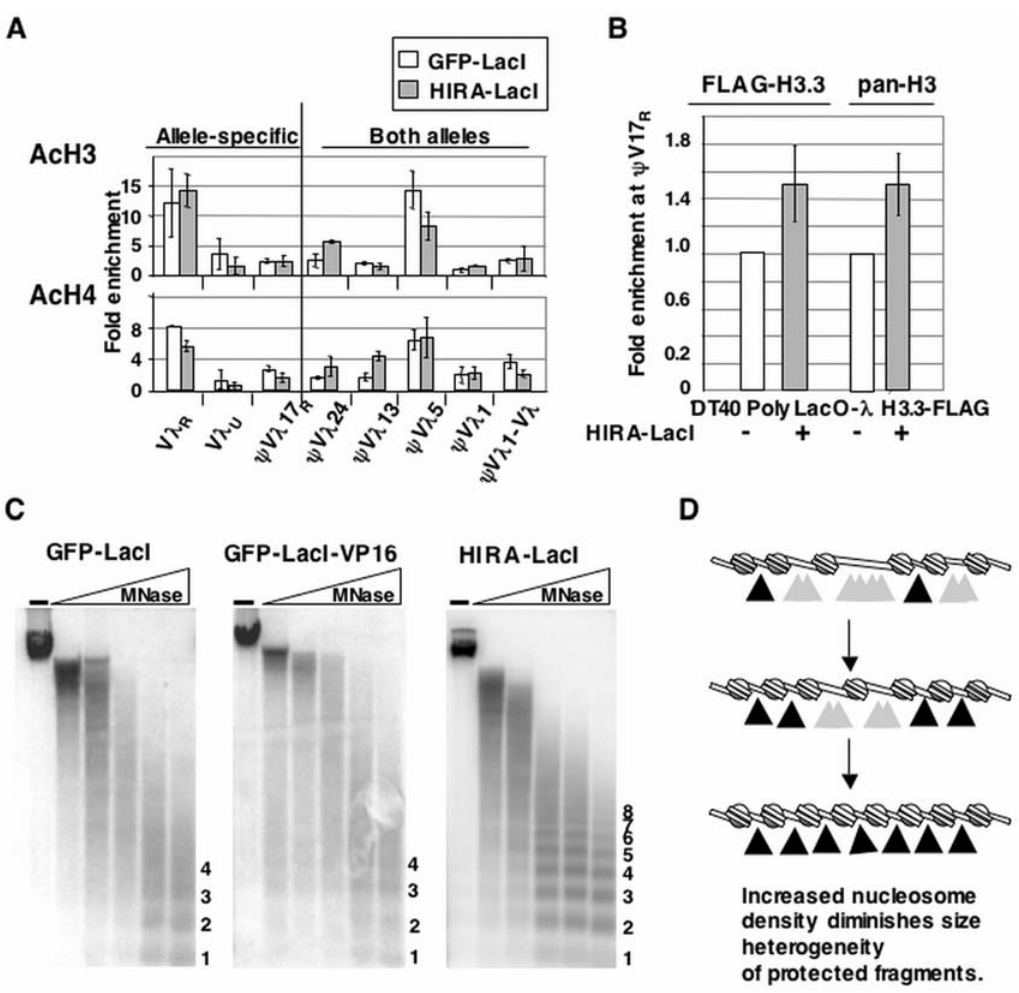
Figure 5. Tethered HIRA Enriches Local Levels of H3.3 and Alters Local Chromatin Structure. (A) Quantitation of enrichment of AcH3 (above) and AcH4 (below) at Ig l in DT40 PolyLacO- l GFP-LacI and DT40 PolyLacO- l HIRA-LacI transfectants. Enrichment assayed by ChIP is expressed relative to the total DNA input control, 6 standard deviation of three or more separate amplifications of increasing amounts of template DNA. (B) Quantitation of ChIP analysis of enrichment of H3.3 (FLAG-H3.3) and pan H3 at y V l 17 R in DT40 PolyLacO- l and DT40 PolyLacO- l HIRA-LacI cells expressing H3.3-FLAG, normalized to enrichment in DT40 PolyLacO- l . Bars are shown 6 standard deviation of four separate amplifications of increasing amounts of template DNA. (C) Southern blot analysis of the PolyLacO region in DT40 PolyLacO- l GFP-LacI, DT40 PolyLacO- l GFP-LacI-VP16 and DT40 PolyLacO- l HIRA-LacI transfectants, following digestion of chromatin with micrococcal nuclease (MNase). No Mnase, (-). Numbers at the right denote nucleosome multimers. (D) Model of how elevated histone deposition could diminish size heterogeneity of protected nucleosome fragments. A defined region of DNA experiences nucleosome loading at increased density. Grey arrowheads indicate a range of cleavable positions, which will result in size heterogeneity of the protected fragments; dark arrowheads indicate restricted range of cleavable sites.